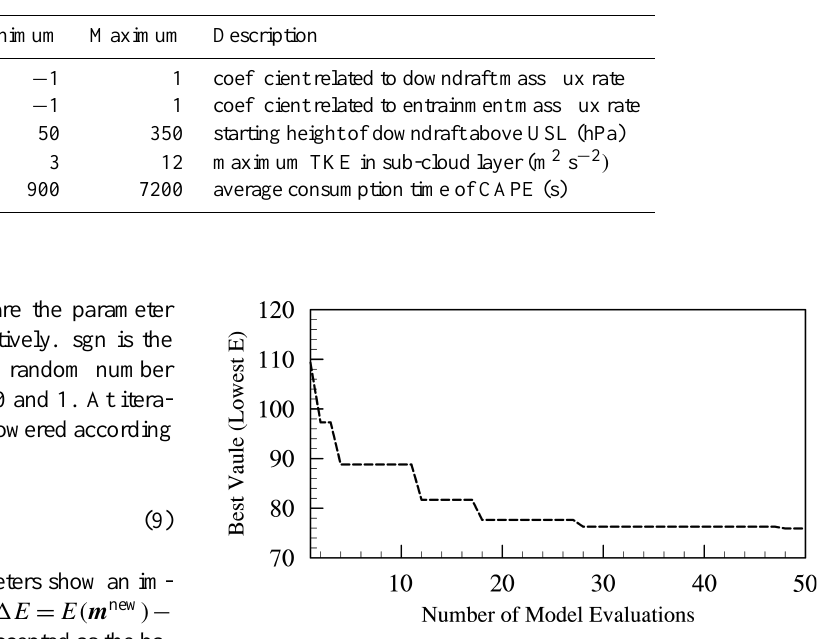
Fig. 1. The best values obtained using MVFSA method as a func- tion of the number of model